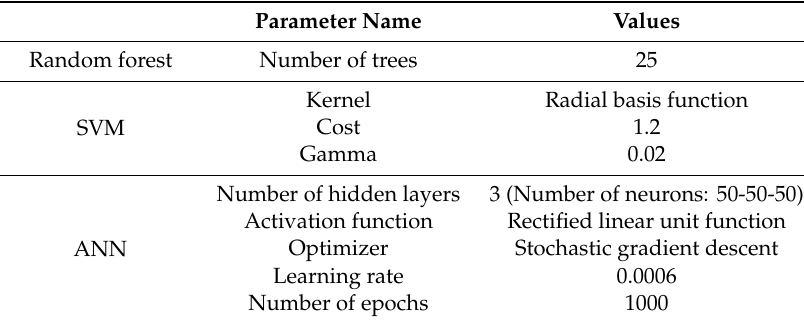
Table 3. Parameters of the used classifiers.